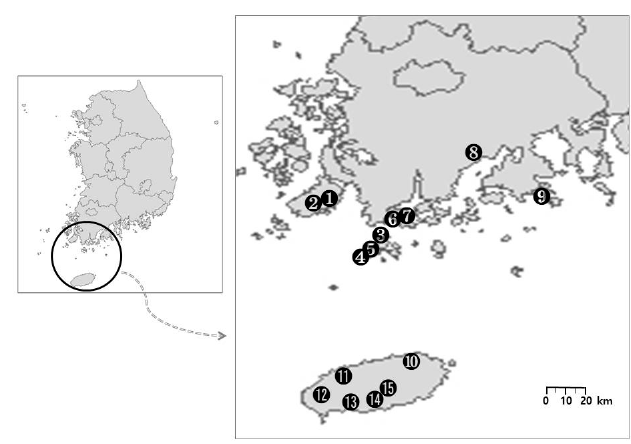
Figure 1. Location map of base populations for candidate tree selection in Quercus salicina and Q. glauca . The numbers in the black circle indicate the No. of stands shown in the Table 1.